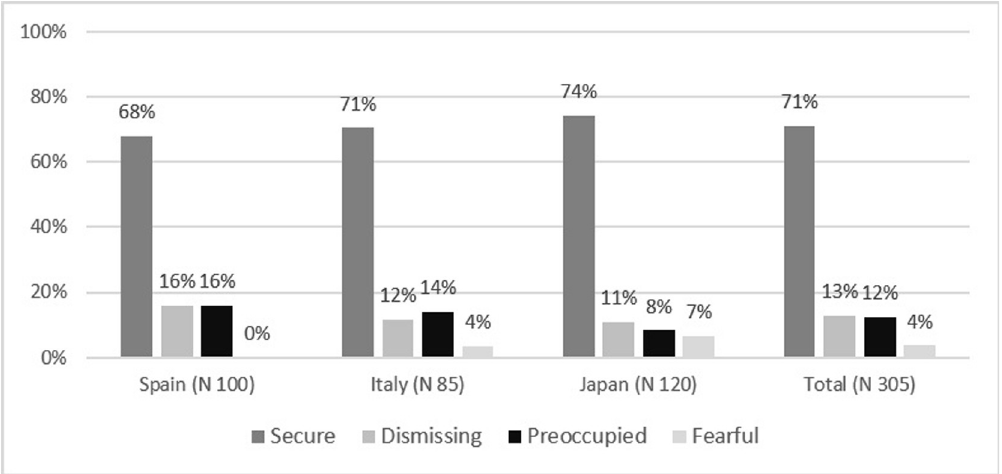
Fig 1. Frequencies of attachment styles derived using the ECR classification by